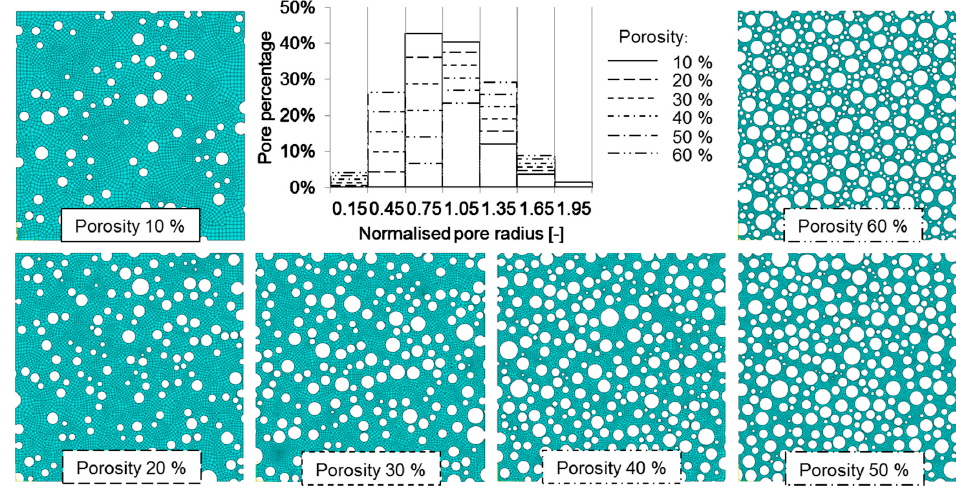
Table 2. Interpolated and extrapolated pore percentages for various porosities.